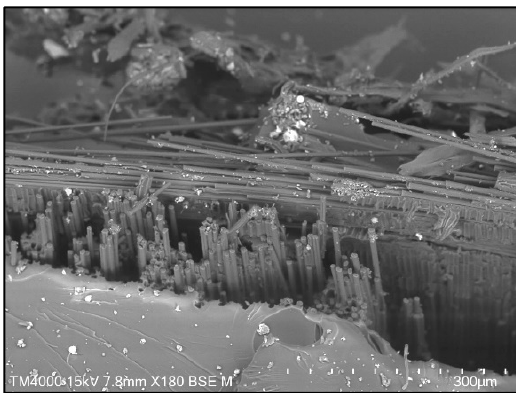
Figure 4. Surface morphology of pure CF/epoxy composite.